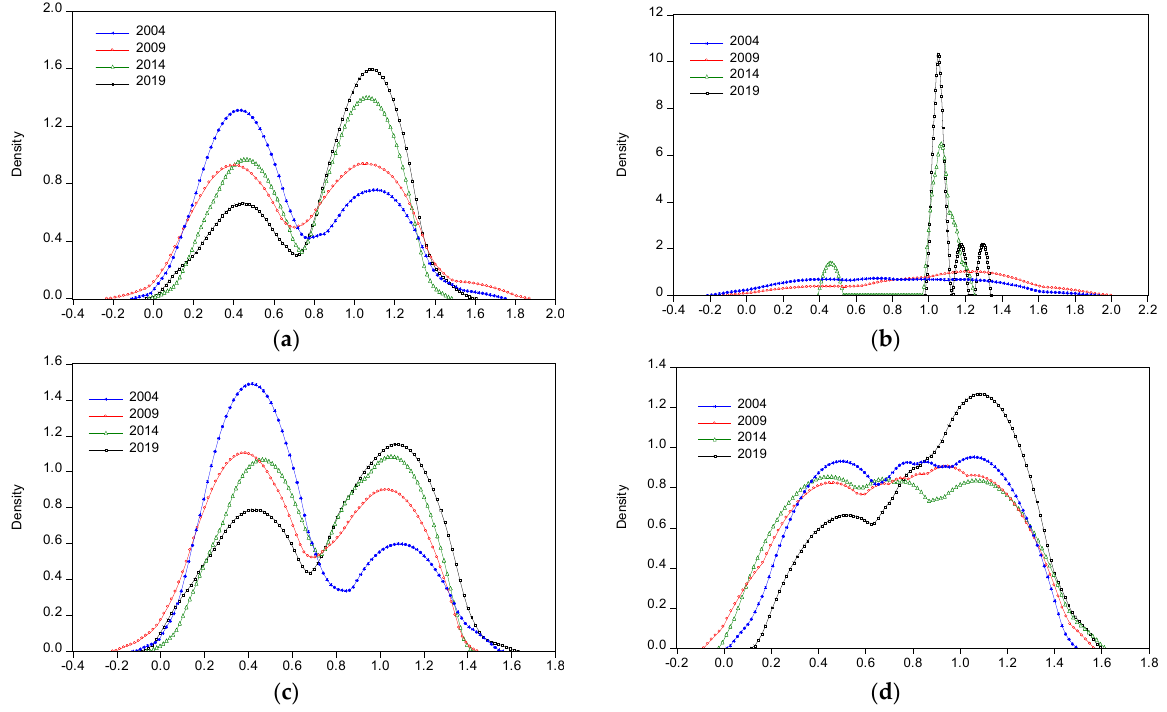
Figure 5. Evolution of GLUE of resource-based cities in each area of the YRB. ( a ) The YRB; ( b ) Up- stream area; ( c ) Midstream area; ( d ) Downstream